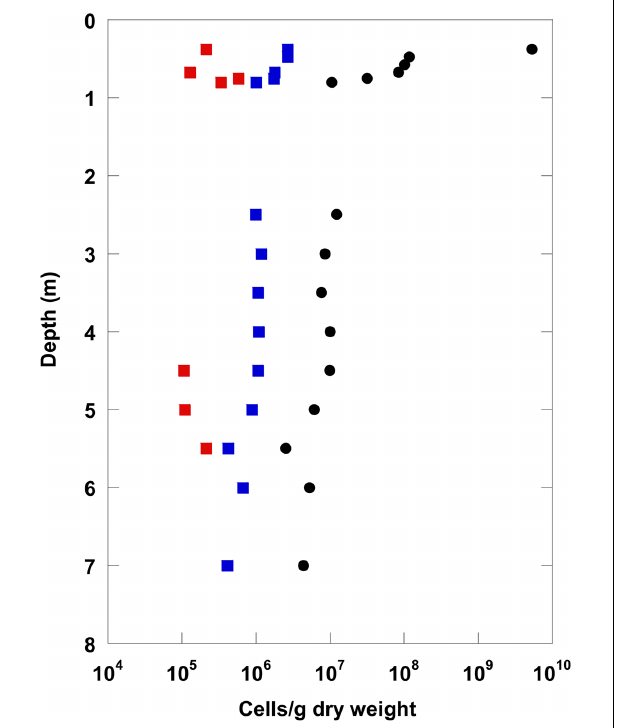
FIGURE 2 | Catalyzed reporter deposition–fluorescence in situ hybridization numbers for Bacteria (blue) and Archaea (red) displayed with total cell counts (black:Weinbauer et al., 1998) for the uppermost 8m of the terrestrial CBIS post-impact